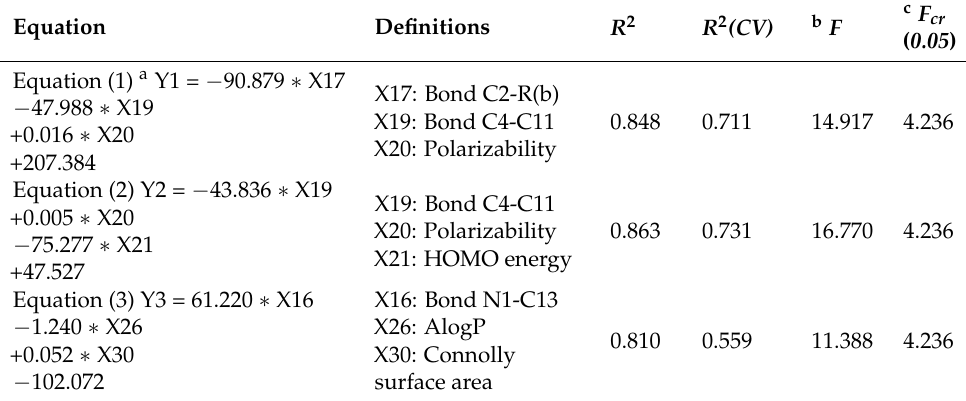
Table 1. QSAR model results via the GA-MLR